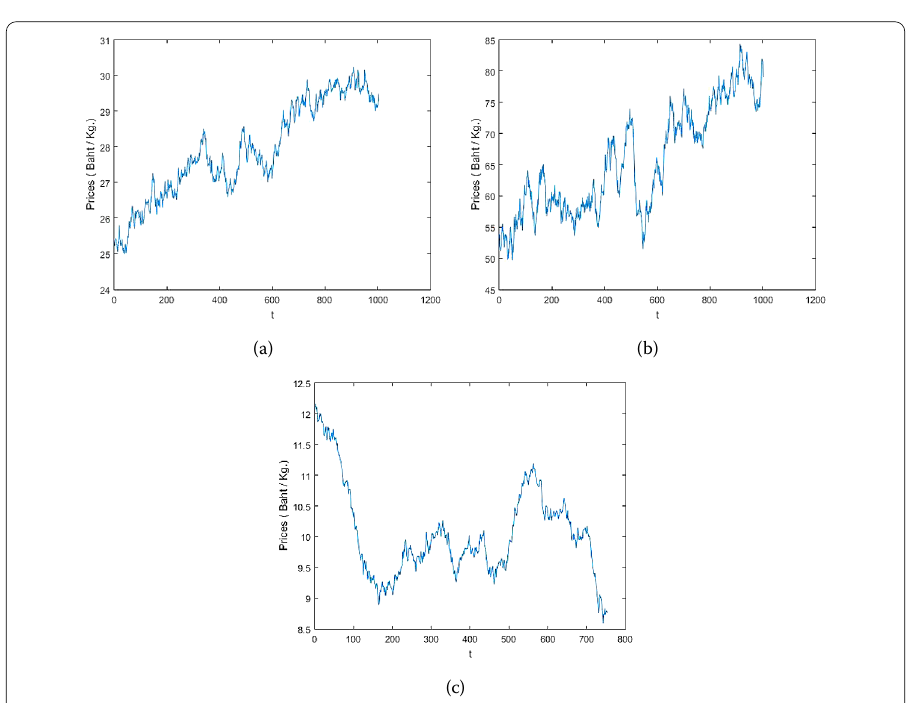
Figure 3 Results of simulation with Ornstein-Uhlenbeck process with λ = 1: (a) Results of simulation with Ornstein-Uhlenbeck process of BHMR with λ = 1. (b) Results of simulation with Ornstein-Uhlenbeck process of RSS3 with λ = 1. (c) Results of simulation with Ornstein-Uhlenbeck process of TS with λ =